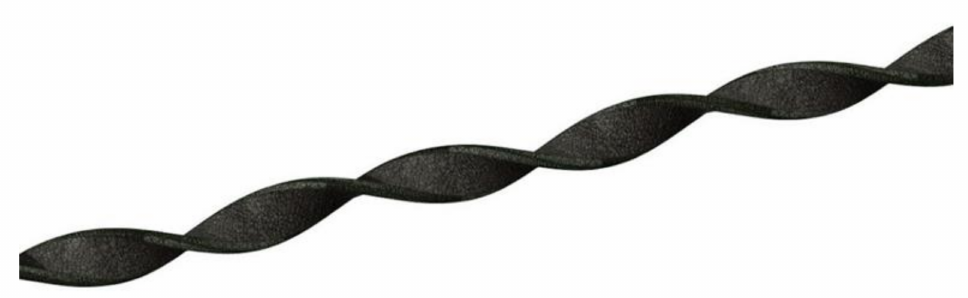
Figure 1. Pili torti, characterized by the presence of the hair shaft flattened and twisted 180 ◦ along its long axis. Reproduced with permission from J. Taczała,